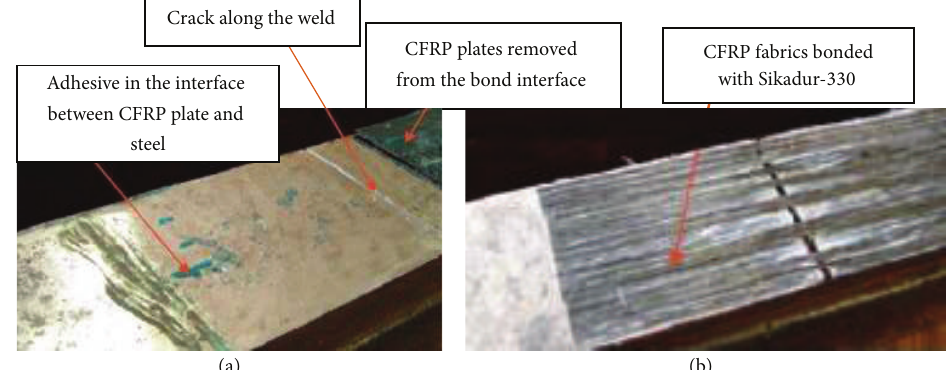
Figure 12: Debonding interface of retrofitted beams using (a) CFRP plates; (b) CFRP sheets